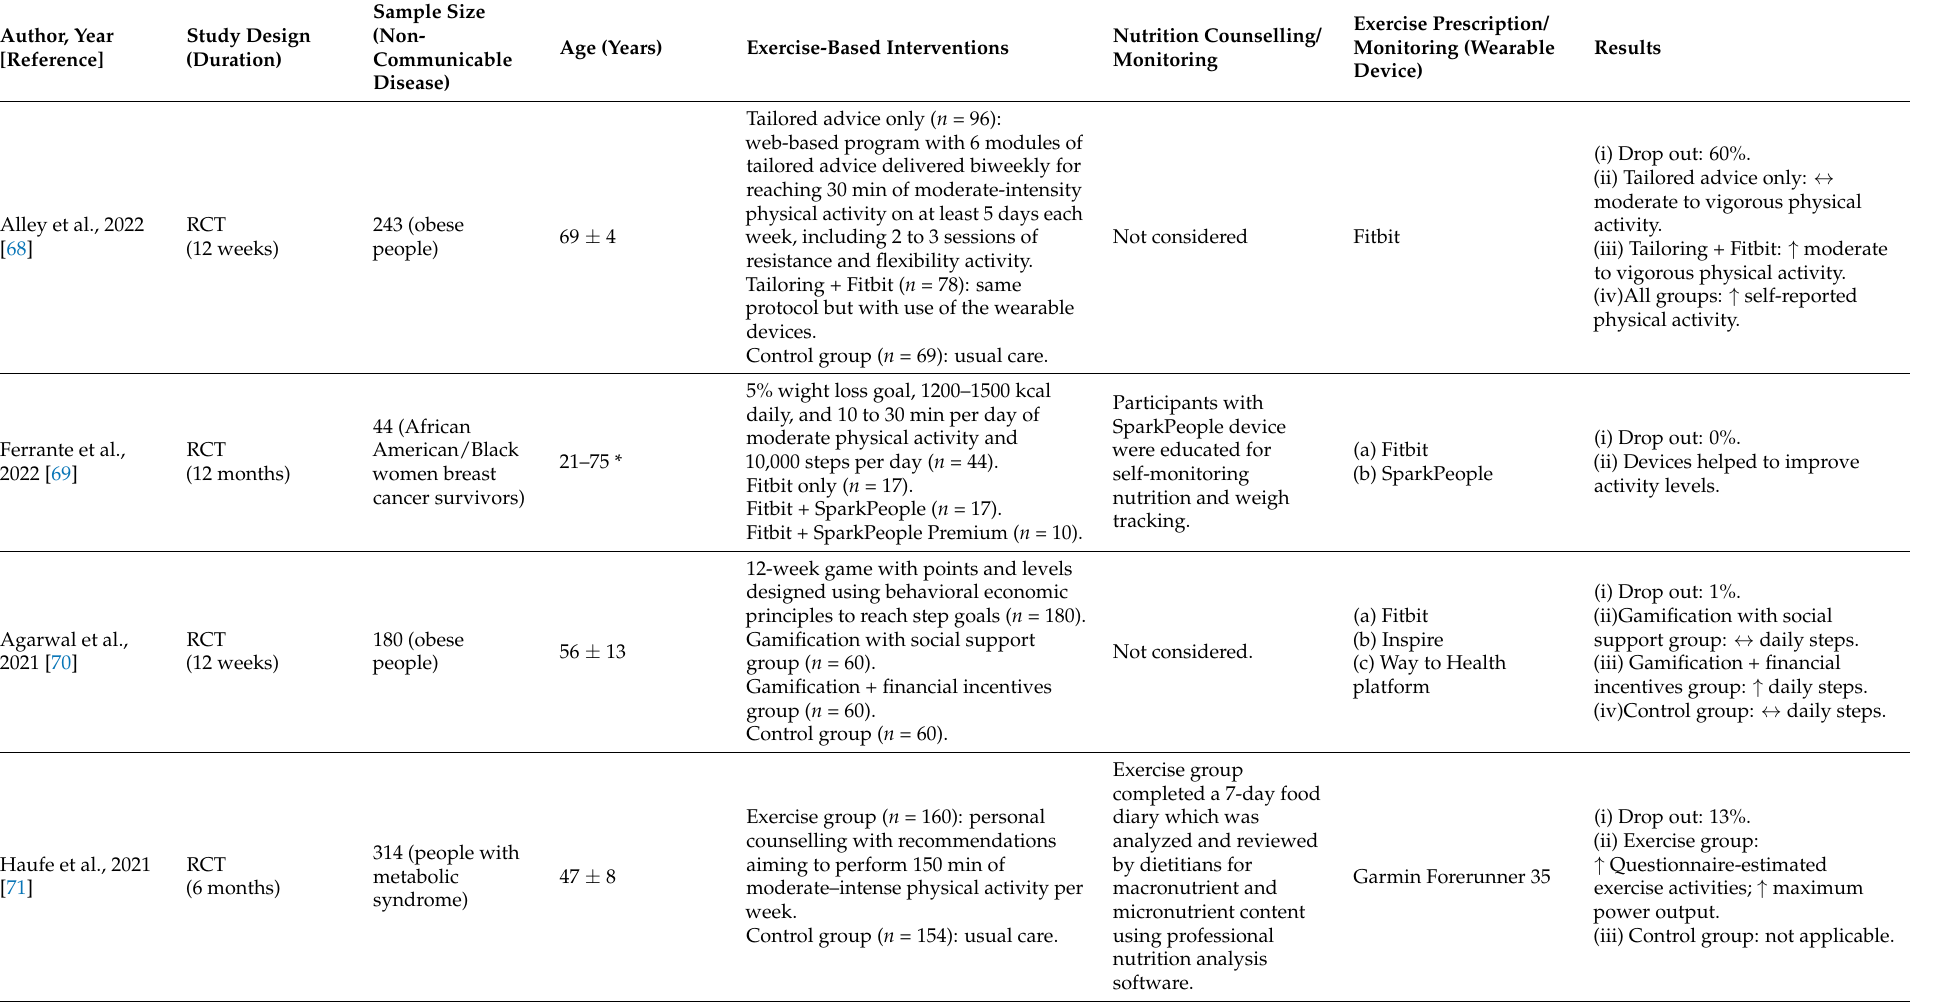
Table 1. Summary of the exercise- and nutrition-based intervention and wearable devices for health-related outcomes of the included